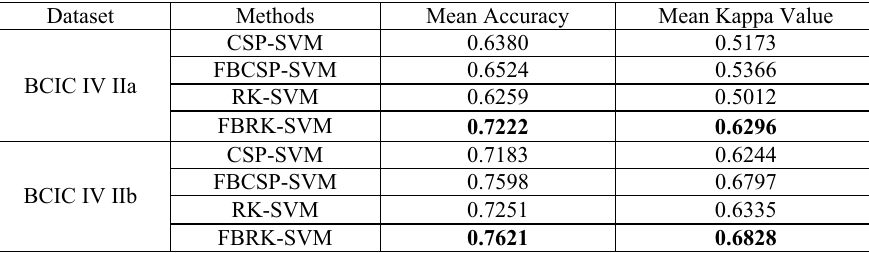
Table 1. Performance of compared methods on the test set of MI